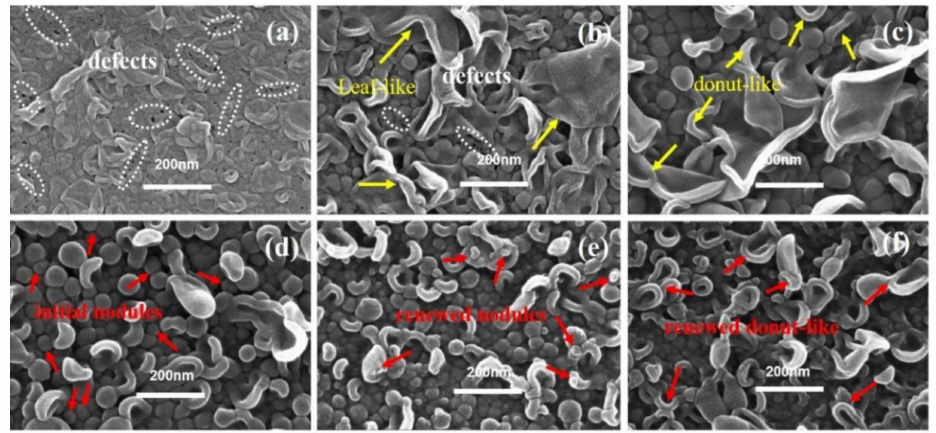
Figure 4. SEM image of PA’s top surface in series 2. ( a – f ): TFC − 7~TFC −